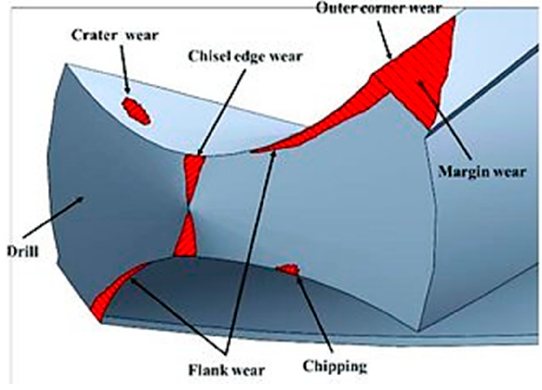
Figure 8. Drill bit wear [78].